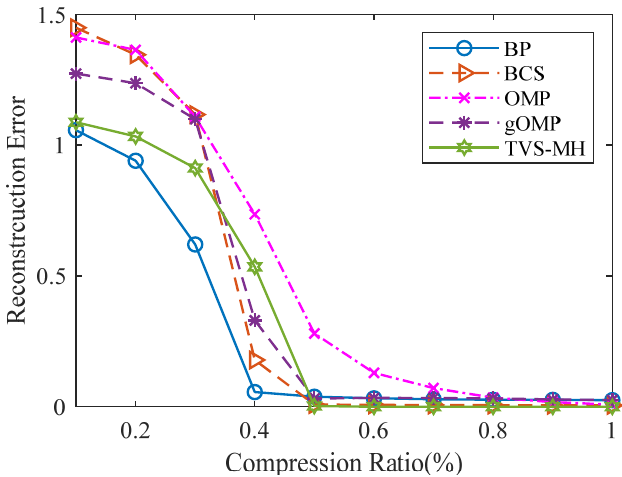
Figure 11. The relation between the reconstruction error and the compression ratio for the same sparse gas signal using different reconstruction algorithms.